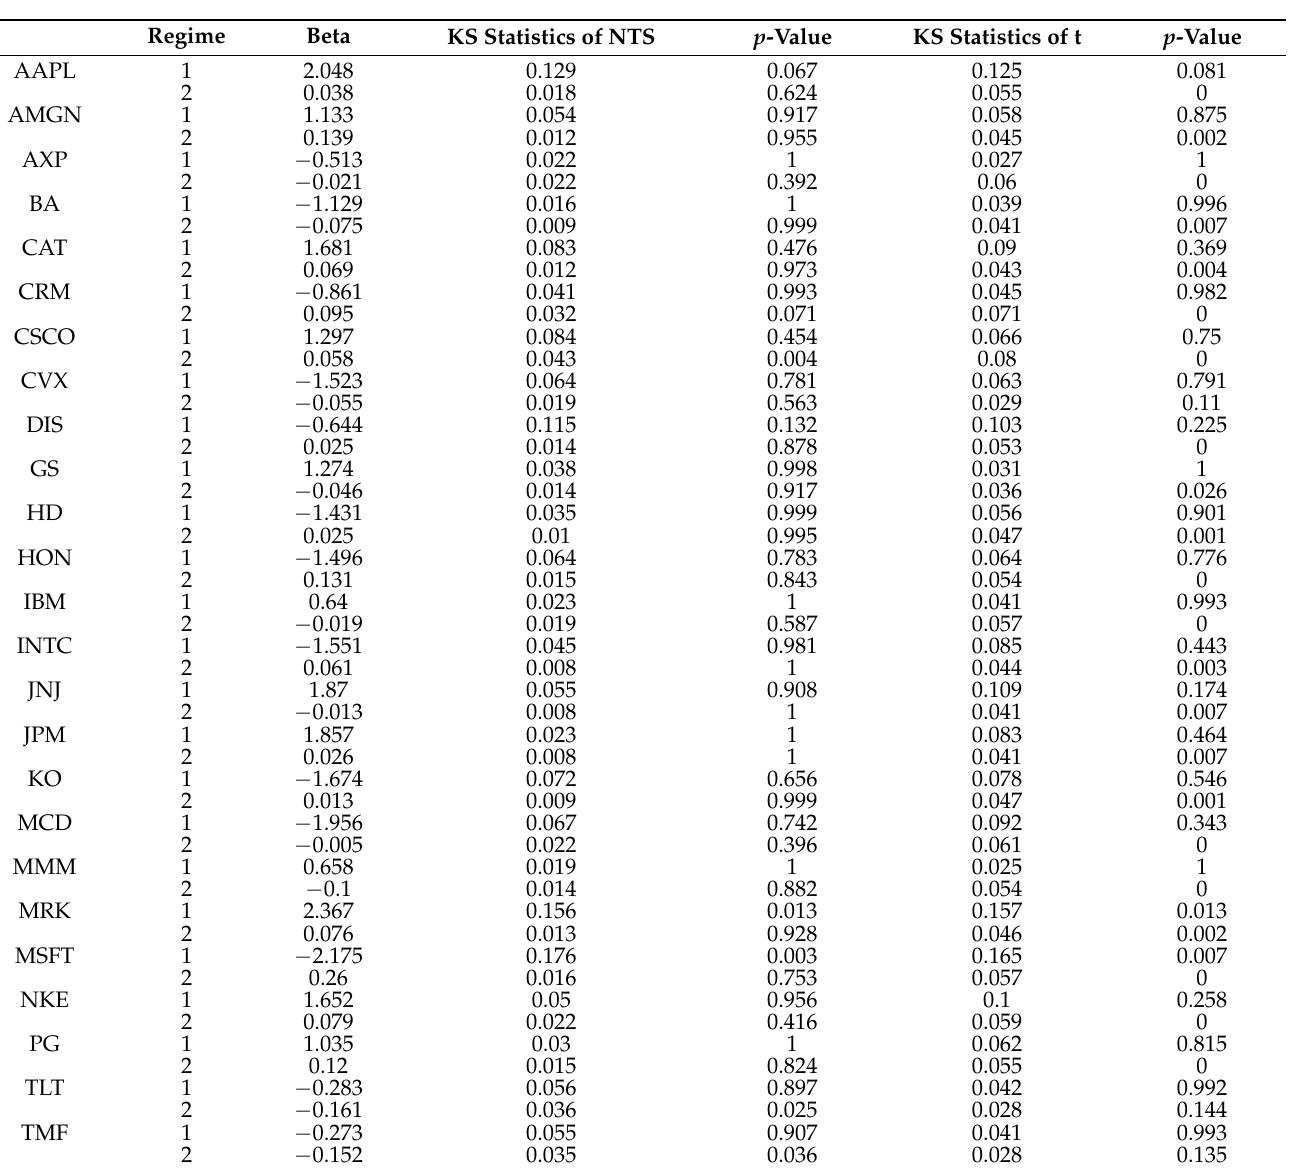
Table 1. Kolmogorov–Smirnov tests on marginal distributions of joint